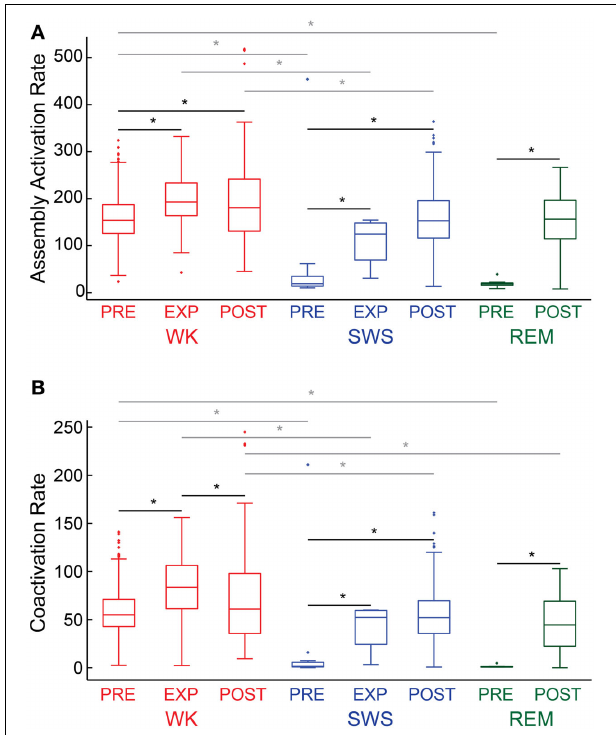
FIGURE 6 | Descriptive statistics. Panels show the distribution of assembly activation rate (A) and co-activation rate (B) (events per second) during different behavioral states and experimental periods for rat # 5. Behavioral states boxplots are color coded as red, blue, and green for WK, SWS and REM, respectively. Experimental periods (PRE, EXP and POST) are placed together and in chronological sequence within each behavioral state. Black lines with asterisks reflect significance between two different experimental periods within a given behavioral state. Gray lines with asterisks reflect significance between two different behavioral states within a given experimental period ( p < 0 . 05, bootstrap corrected for multiple